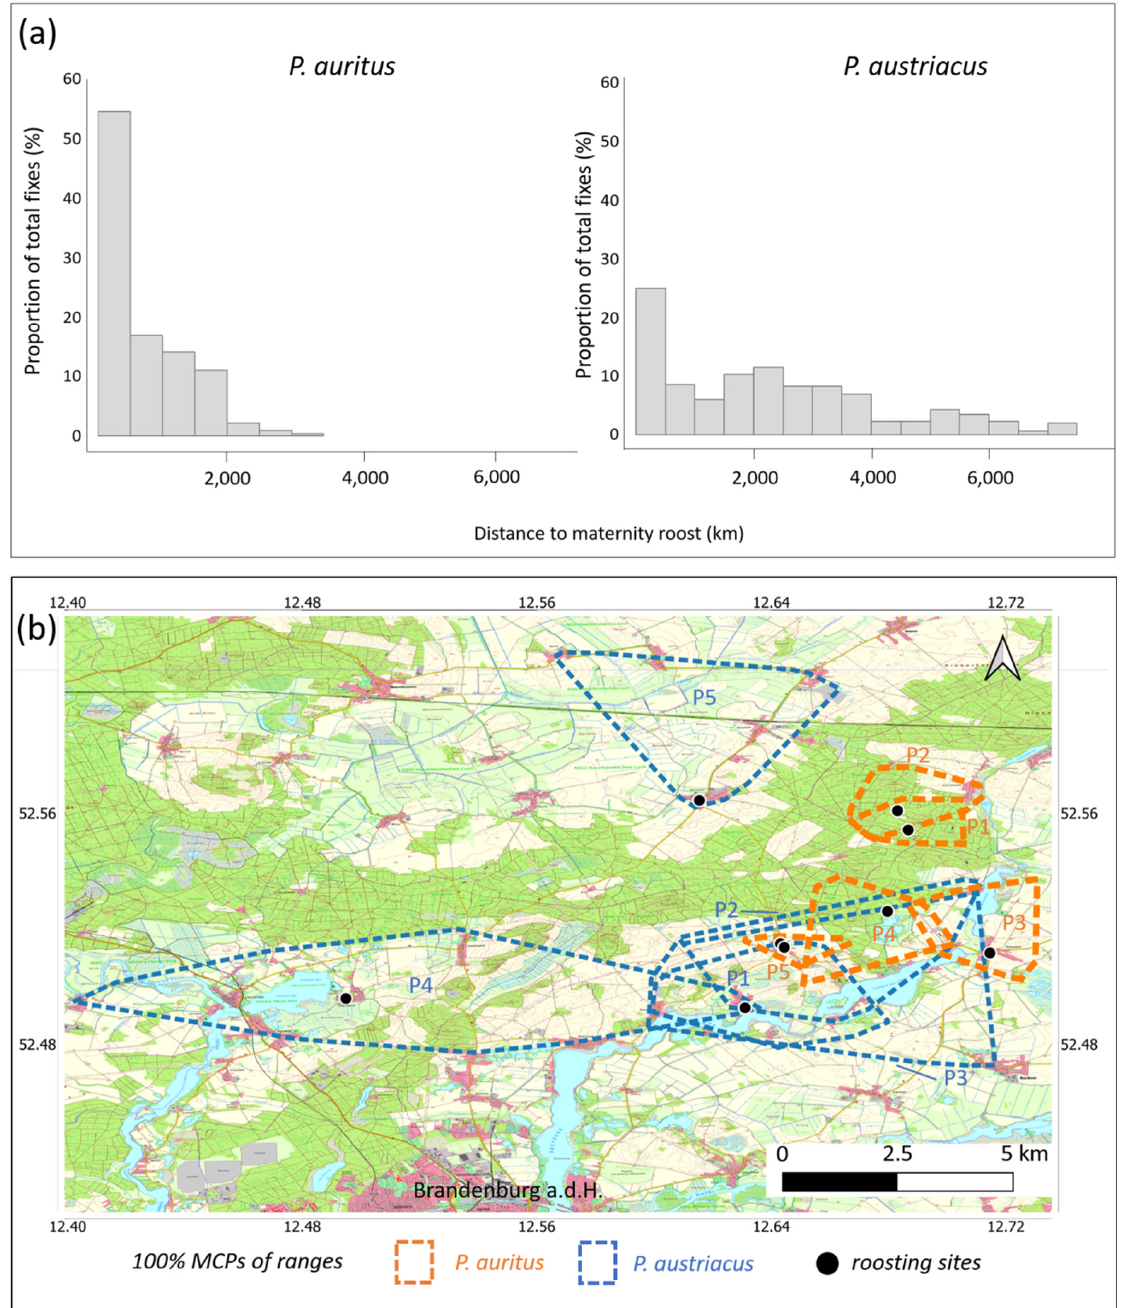
Figure 3. (a ) Frequency distribution of recorded distances from the maternity colony of each five female P. auritus ( n = 332 locations, left) and P. austriacus ( n = 362 locations, right); ( b ) range outlines (100% MCPs) of P. auritus ( n = 5 females, orange) and P. austriacus ( n = 5 females, blue) radio-tracked in the nature park Westhavelland during 2013 − 2015.